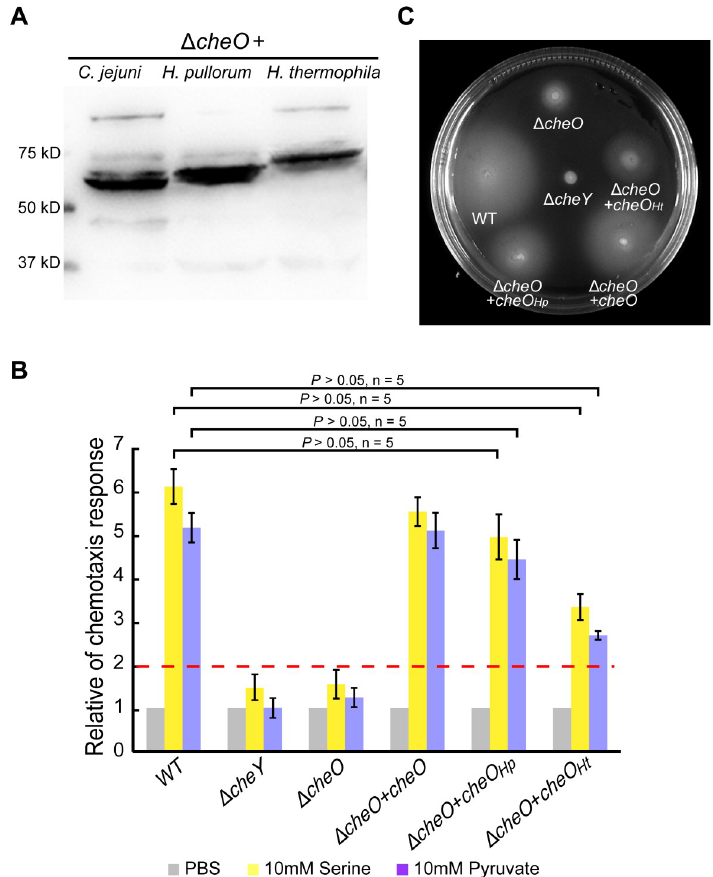
Fig 6. Functional conservation of CheO in Campylobacterota species. (A) Immunoblotting of CheO homologs from C . jejuni , Helicobacter pullorum and Hydrogenimonas thermophila that were fused with 3X FLAG-tag and expressed in C . jejuni Δ cheO mutant. The blot was probed with anti-FLAG antibodies. (B) Capillary chemotaxis assays of C . jejuni wild-type and Δ cheO mutant strains complemented with various CheO homologs. Data are shown as the mean ± SD (n = 5). The differences between the cheO isogenic mutants and wild-type were tested using Student’s t -tests. (C) Soft agar motility assay of C . jejuni wild-type and Δ cheO mutant strains complemented with various CheO homologs. Δ cheY mutant as a negative